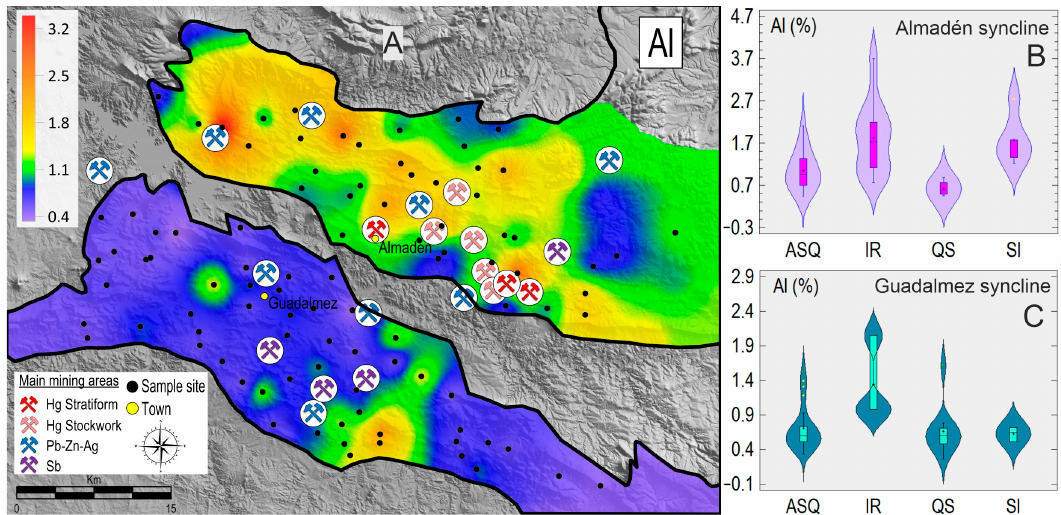
Figure 4. Spatial distribution maps ( A ) and violin plots ( B , C ) of major elements (all data are expressed as a percentage). ASQ: alternations of shales and quartzites, IR: igneous rocks, QS: quartzites and sandstones, Sl: slates.